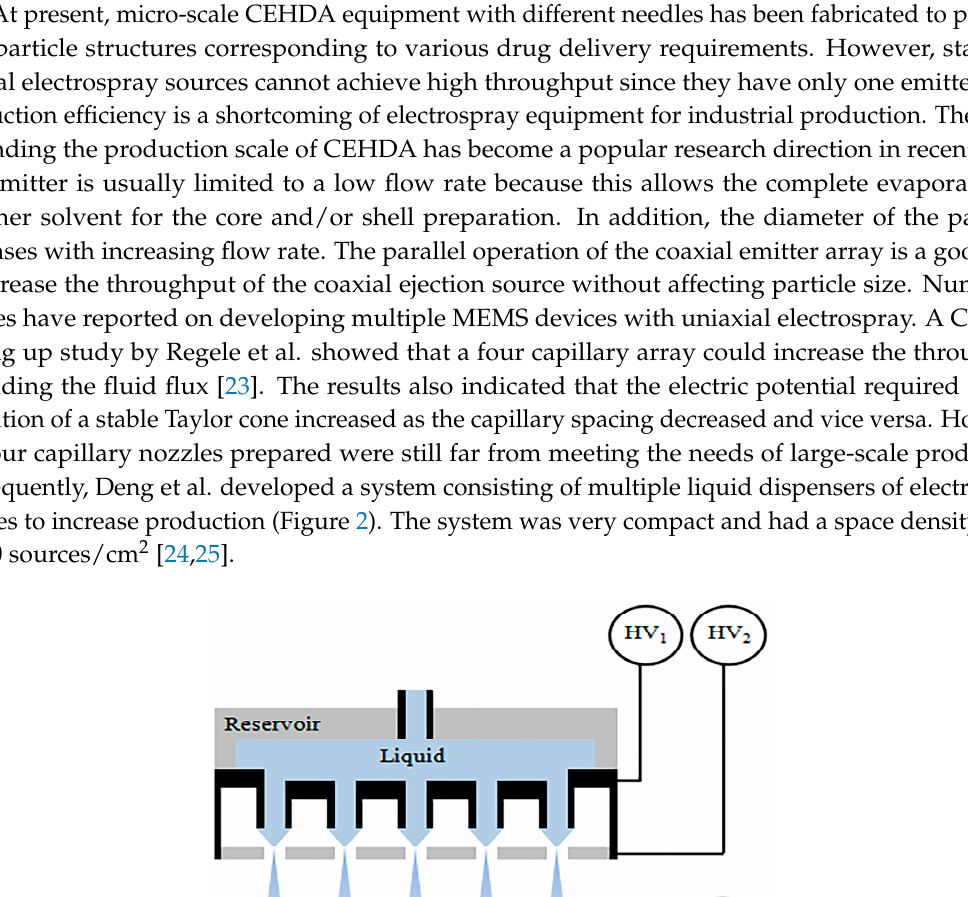
Figure 1. Typical experimental setup.